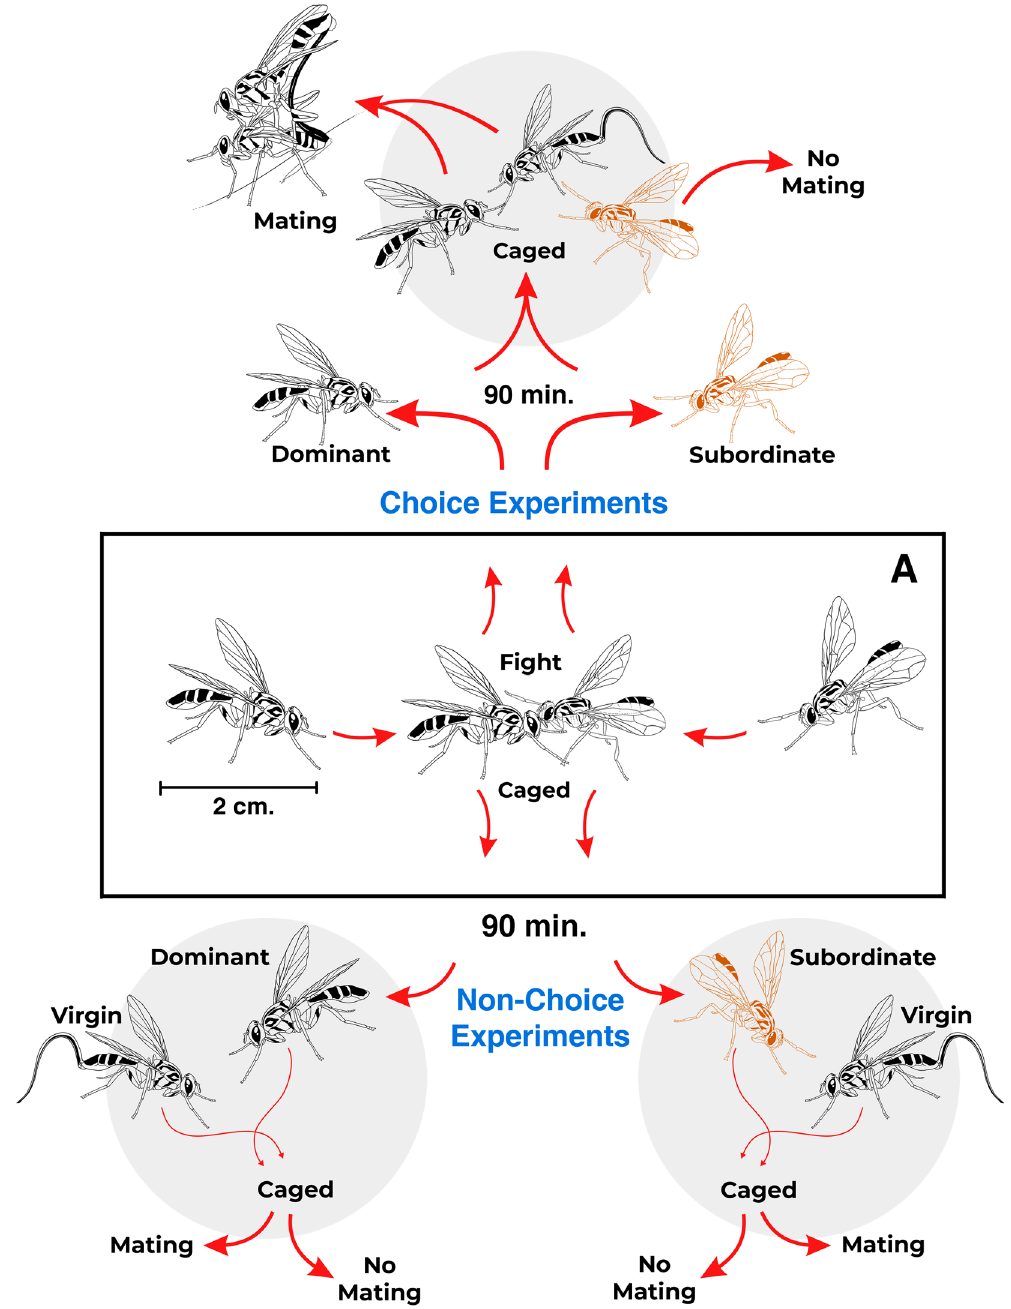
Figure 7. Experimental sequence for the establishment of dominance (hierarchy) among Anastrepha curvicauda males and subsequent mate choice and no-choice experiments. The experiment starts when two males of similar age and body weight were caged (A) and agonist behavior was quantified for 60 min. Ninety minutes after the hierarchy was established one male was classified as dominant and the other as subordinate (colored reddish, see text for details). The choice experiment (upwards in the sequence) involved three individuals: a dominant and a subordinate male (their hierarchy among them was established 90 min) and a virgin female caged for 60 min. The non-choice experiment involved 2 individuals: a male either dominant or subordinate and a virgin female caged for 60 min. In both experiments, the insects’ behavior was filmed and registered the male achieving the